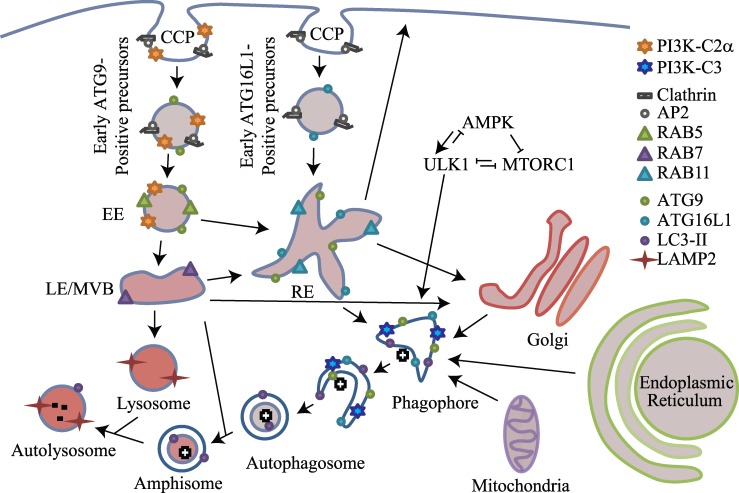
Proposed model for how PI3K-C2α may facilitate the integration of endocytic membrane sources into the autophagy pathway through the recycling endosome.Model highlighting PI3K-C2α localization in the endocytic and autophagy pathways. Abbreviations: CCP: clathrin-coated pit; EE: early endosome; LE: late endosome; MVB: multi-vesicular body; RE: recycling endosome.